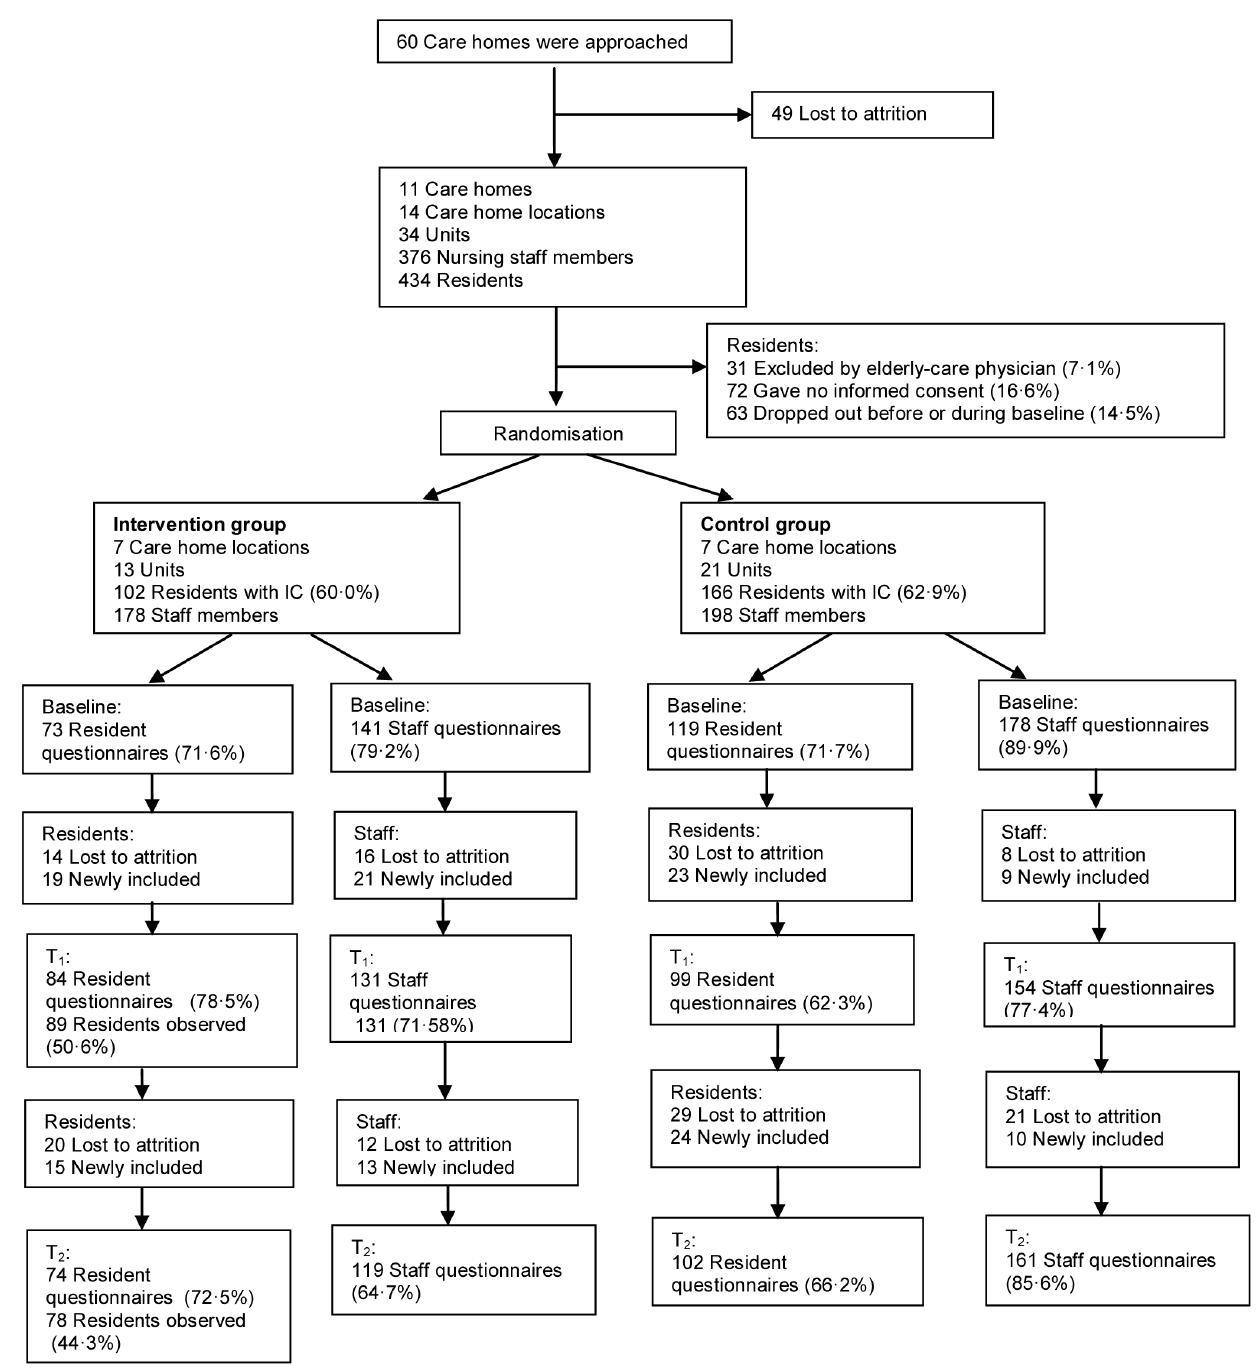
Figure 1. Flowchart detailing numbers of residents and staff.